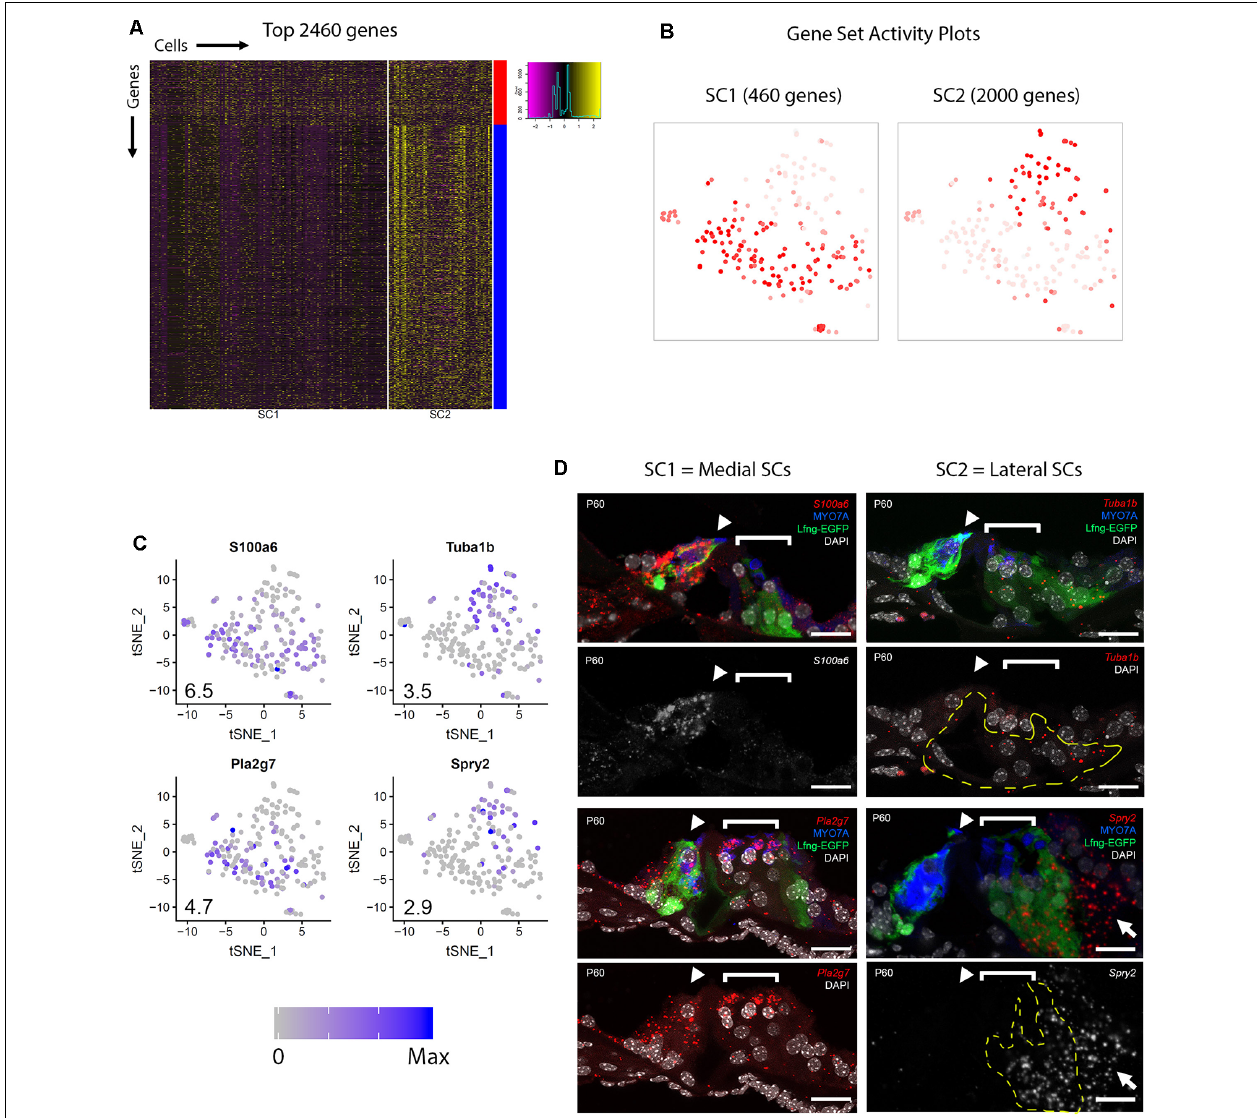
FIGURE 3 | Adult cochlear SCs can be categorized into two subpopulations. (A) Heatmap depicting the top 2,460 genes expressed by the two clusters of adult cochlear SCs (SC1, SC2). For SC1, only 460 genes met criteria for significance, while for SC2, 2,000 genes that met criteria for significance were identified (see “Materials and Methods” section). Cells are arrayed along the horizontal axis and genes are arrayed along the vertical axis. Two main clusters of genes are distinguished by the color bars on the vertical axis to the right of the heatmap with the red bar corresponding to SC2 and the blue bar corresponding to SC2. (B) Gene set activity plots to demonstrate composite gene expression projected onto feature plots in SC1-defining (red bar, 460 genes) and SC2-defining (blue bar, 2,000 genes). Despite the visually apparent presence of some SC1-defining genes in the SC2 cluster of SCs, SC1-defining genes as a composite appear to define the SC1 adult cochlear SC subpopulation. (C) Feature plots of 1 known ( Tuba1b ) and 3 previously uncharacterized ( S100a6 , Pla2g7 , Spry2 ) genes show differential expression between SC1 and SC2 SC subpopulations. S100a6 and Pla2g7 correspond to SC1 (red gene cluster in panel A ) and Tuba1b and Spry2 correspond to SC2 (blue gene cluster in A ). Numbers in the bottom left corner of the feature plots represent maximum expression level (Max) among adult cochlear SCs. The expression histogram is shown with blue indicating higher expression. (D) smFISH localization of RNA expression for these four candidate genes. Below each color image with the RNA probe color designated in italics is either a grayscale single channel of the smFISH RNA probe or the smFISH RNA probe channel with DAPI-labeling of nuclei. S100a6 and Pla2g7 demonstrate higher levels of transcript expression in the medial SCs (inner border, inner phalangeal cells) while Spry2 demonstrates higher levels of transcripts in the lateral SCs (predominantly Deiters cells as denoted by yellow-dashed line outline but also noted in Hensen’s cells as denoted by white arrow). Expression of Tuba1b transcripts can be seen in lateral SCs (pillar and Deiters cells) in the top image with Lfng-EGFP in green, MYO7A in blue (HCs) and DAPI-labeling of nuclei in the top right image for the Tuba1b RNA probe. The region of the lateral SCs (pillar and Deiters cells) is identified by the dashed yellow line in the Tuba1b smFISH probe image with DAPI-labeling of nuclei. HCs are labeled with MYO7A (blue), cell nuclei are labeled with DAPI (white) and Lfng-EGFP transgene expression (green) in SCs. The IHC (arrowheads) and OHC regions (bracket) are indicated. S100a6 = S100 calcium-binding protein a6 gene; Pla2g7 = Phospholipase A2 Group VII gene; Tuba1b = Tubulin alpha 1b gene; Spry2 = Sprouty RTK signaling antagonist 2; MYO7A = myosin 7A protein; DAPI = 4’,6-diaminodino-2-phenylindole; Scale bar in all panels, 20 µ m.